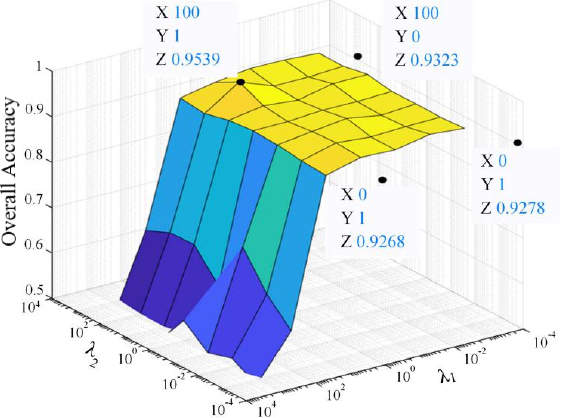
Figure 6. The classification OA under different regularization parameters λ 1 and λ 2 .